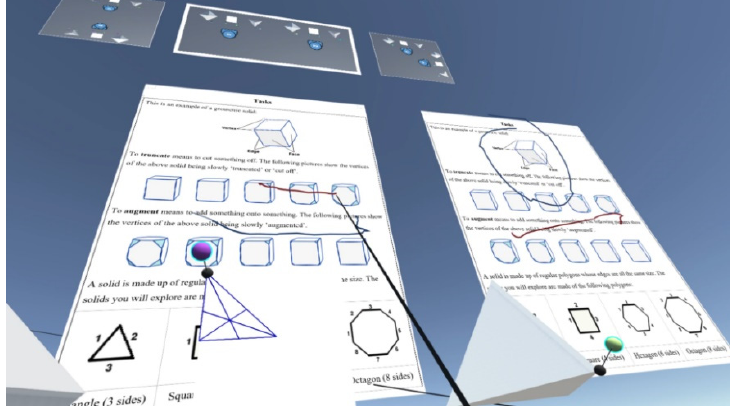
Figure 2. Screenshot of the process of one user taking notes in the task panel using the pen function.